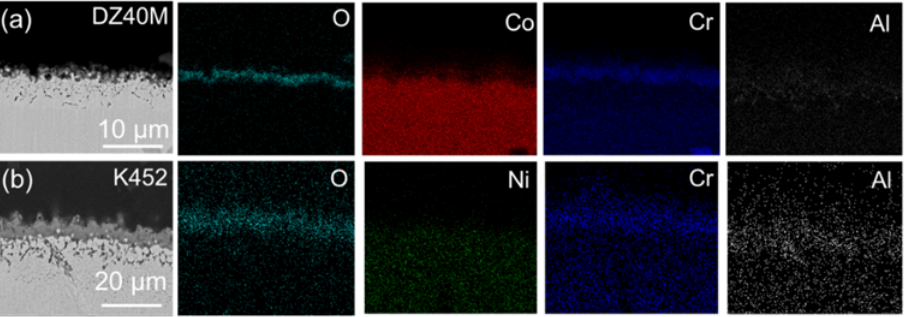
Figure 10. Cross-sectional morphology and EDS-mapping of DZ40M and K452 oxidation for 10 h. ( a ) DZ40M, ( b ) K452.